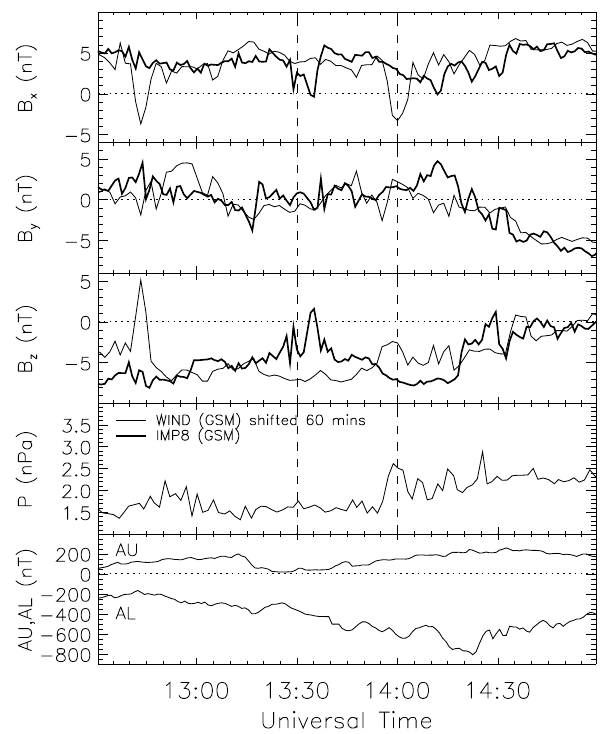
Fig. 2. Overview of the geophysical conditions on 11 February 1998. The dashed vertical lines in each panel mark the period of the reconnection analysis. The top three panels show the interplan- etary magnetic field measured by the Wind (faint line) and IMP-8 (bold line) spacecraft. The Wind data have been lagged 60 min in time to allow for the propagation time from Wind to IMP-8 (see text for position of the spacecraft). The fourth panel shows the solar wind dynamic pressure determined from Wind data, lagged by 60 min. The fifth panel shows the AU and AL indices for the